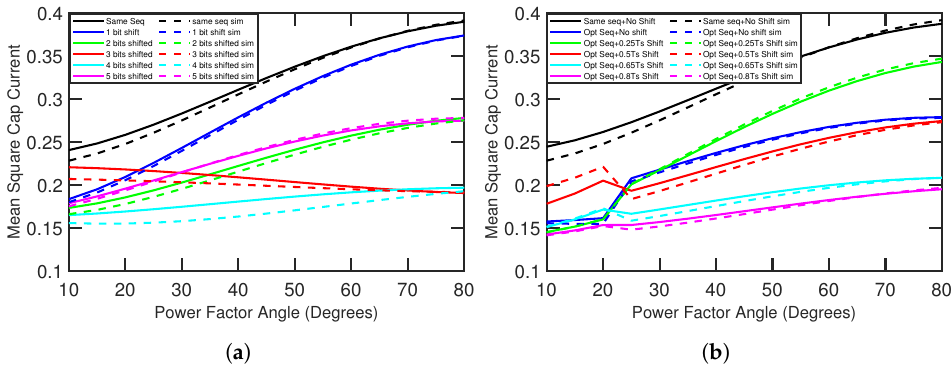
Figure 14. Simulation results compared with the numerical results for RMS cap current for ( a ) se- quence shifts and ( b ) sequence+discrete time